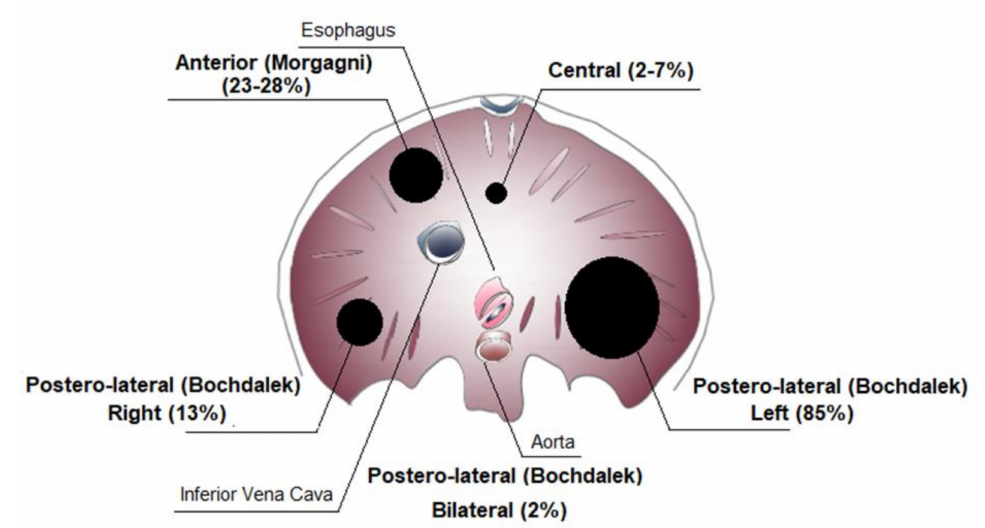
Figure 2. Congenital diaphragmatic hernia (CDH) classification. The size of the defect can range from small to the most extreme variant consisting of complete agenesis